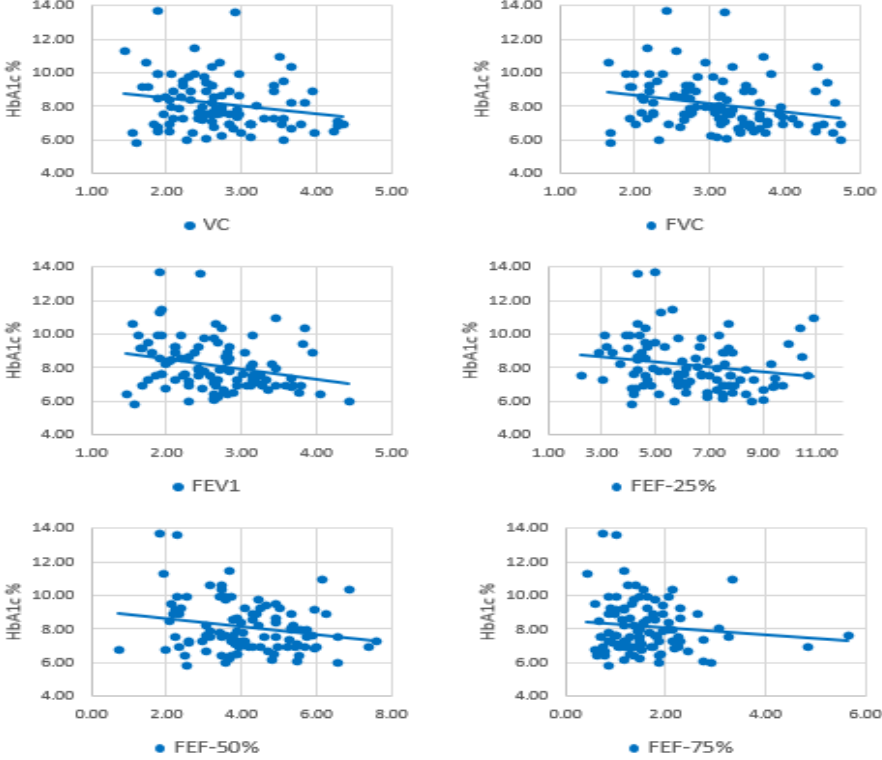
Figure 1 . Correlation analysis between HbA1c and lung function parameters . Figure 1. Correlation analysis between HbA1c and lung function